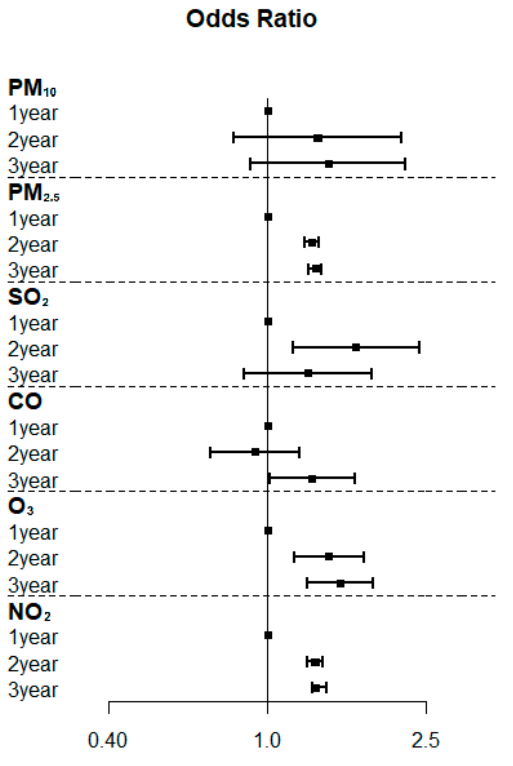
Figure 4. Forest plots of the association between the duration of exposure to air pollutants and the risk of polycystic ovarian syndrome.